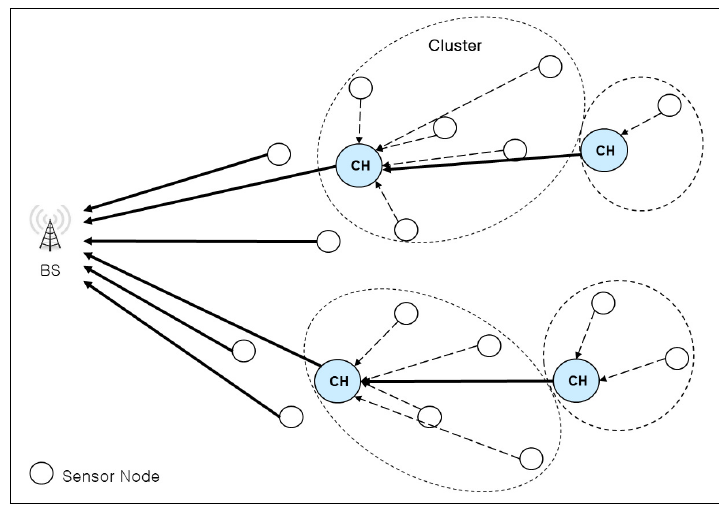
Figure 12. Steady-state of D-LEACH.